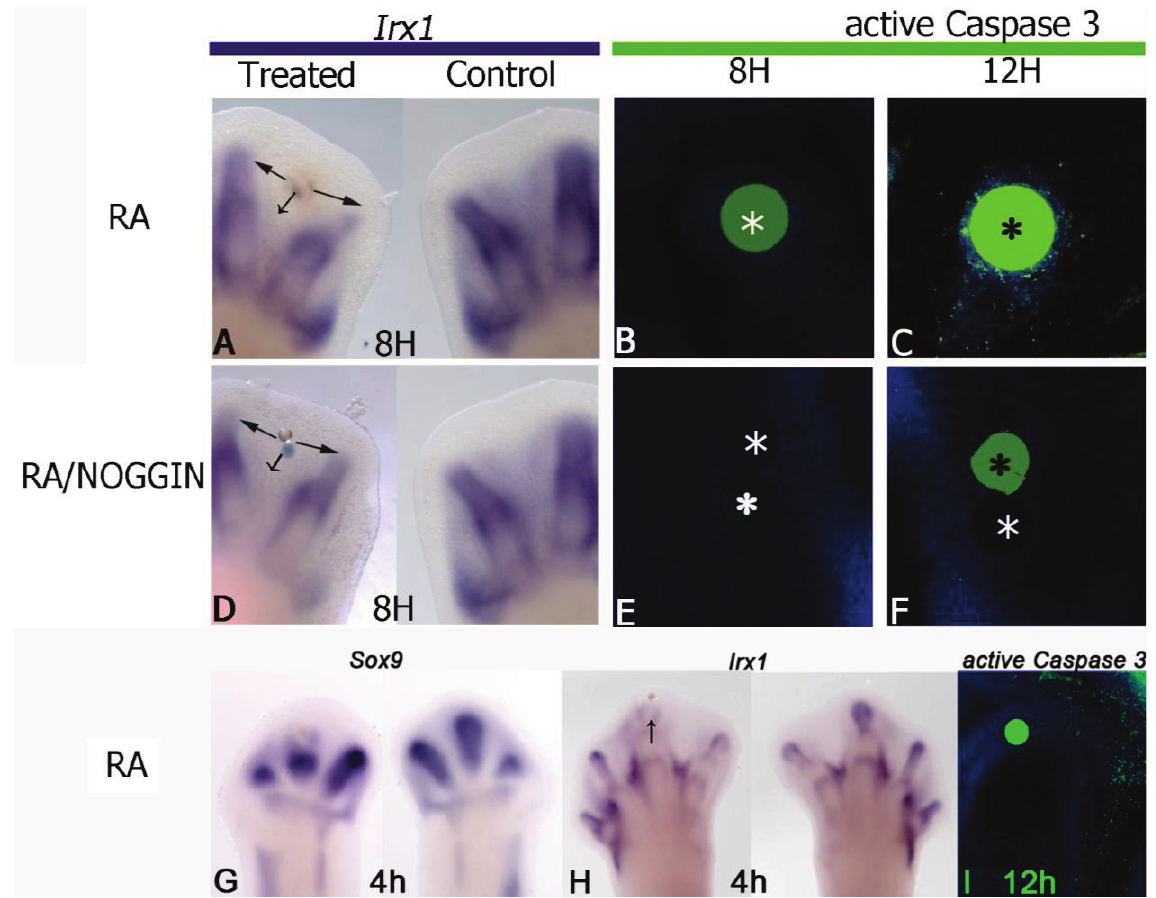
Figure 4. RA inhibits Irx gene expression before the onset of cell death by a BMP-independent mechanism. ( A – F ) Irx1 expression is down‒regulated in th e interdigital area at stage 27HH in chicken hind limbs after 8 hours of RA-treatment and RA/NOGGIN- double treatment. Note that the BMP antagonist NOGGIN does not inhibit the effect exerted by RA on Irx1 expression. ( B , C ) Active caspase 3 (green) is analyzed in the interdigital region of hind limbs after RA treatment for 8 h (B) and 12 h (C). ( C ) The first signs of cell death induced by RA were observed at 12 h. Active caspase 3 was inhibited after RA/NOGGIN-double treatment (E-F), but Irx1 gene expression remained unaffected (D), indicating that RA inhibits Irx expression by a BMP-independent mechanism. ( G – I ) RA inhibits Irx1 at the digit tip before the induction of cell death. Sox9 (G) and Irx1 (H) expression in hind limbs at stage 27HH after 4 h of treatment with RA, and the presence of active caspase 3 (I) at 12 h after the same treatment in the digit tip. Note that down-regulation of Sox9 and Irx1 expression begins before the presence of active caspase 3. In all in situ hybridizations, the experimental samples (A, D, G, H) are presented on the left, whereas controls are on the right. Black arrows in A and D indicate the area of Irx1 inhibition. Black arrows in G and H indicate the bead position. Autofluorescence of ionic-exchange beads used for RA-treatment (black asterisks) is observed as green color. The natural red color of Cy3, used to detect active caspase 3, was changed to green for better visualization of the images. (White asterisks indicate beads soaked in NOGGIN). Modified from